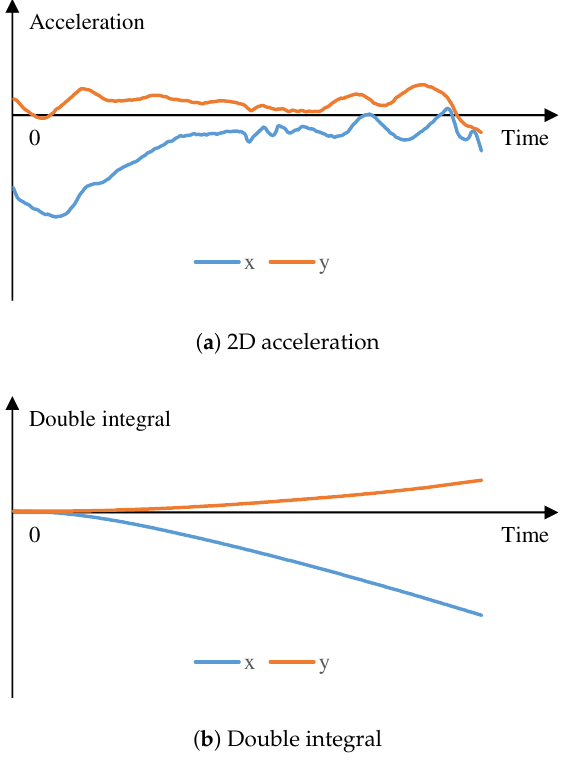
Figure 6. Data of one